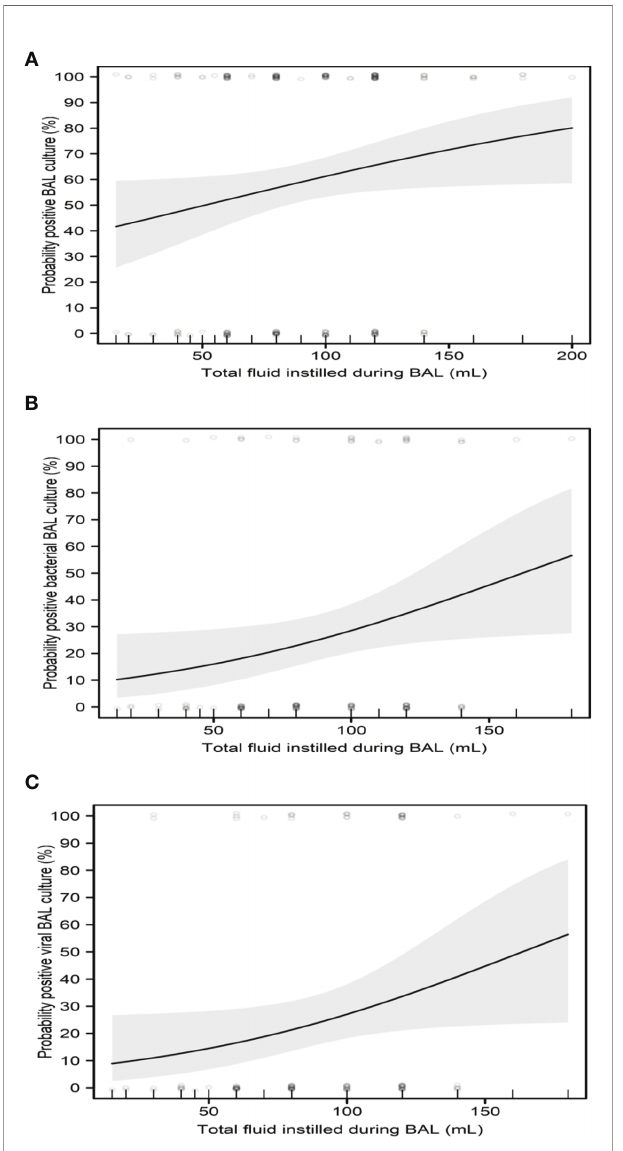
FIGURE 2 | Impact of total fl uid instilled during BAL on culture results. (A) Probability of positive BAL culture. (B) Probability of positive bacterial BAL culture. (C) Probability of positive viral BAL culture. Regression curves are shown as solid lines, bounded by shaded 95% con fi dence intervals. Scatterplots show raw patient measures, jittered slightly for clarity.